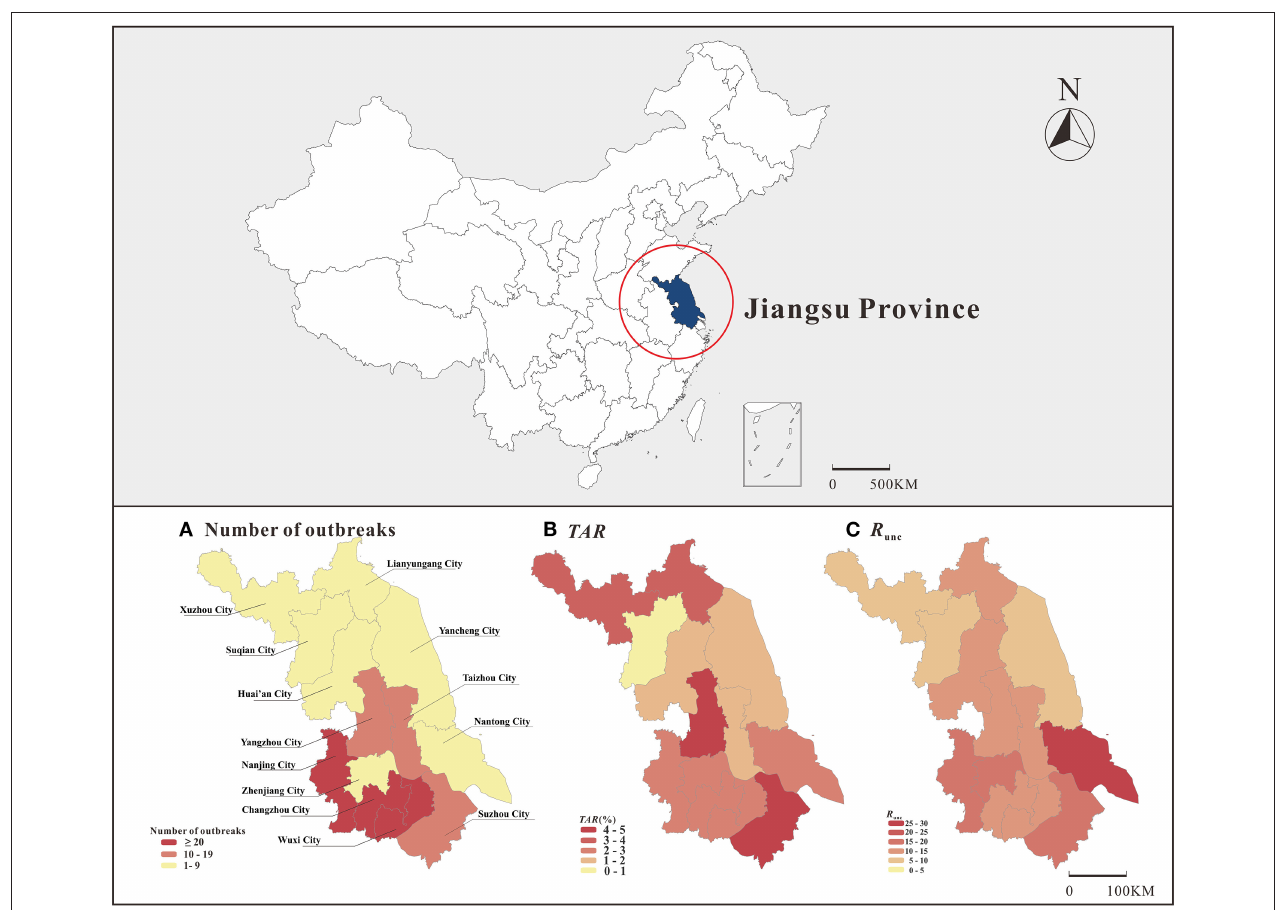
FIGURE 4 | Distribution of number of outbreaks, TAR and transmissibility on map of Jiangsu Province ( A : number of outbreaks, B : TAR , C : R unc ).